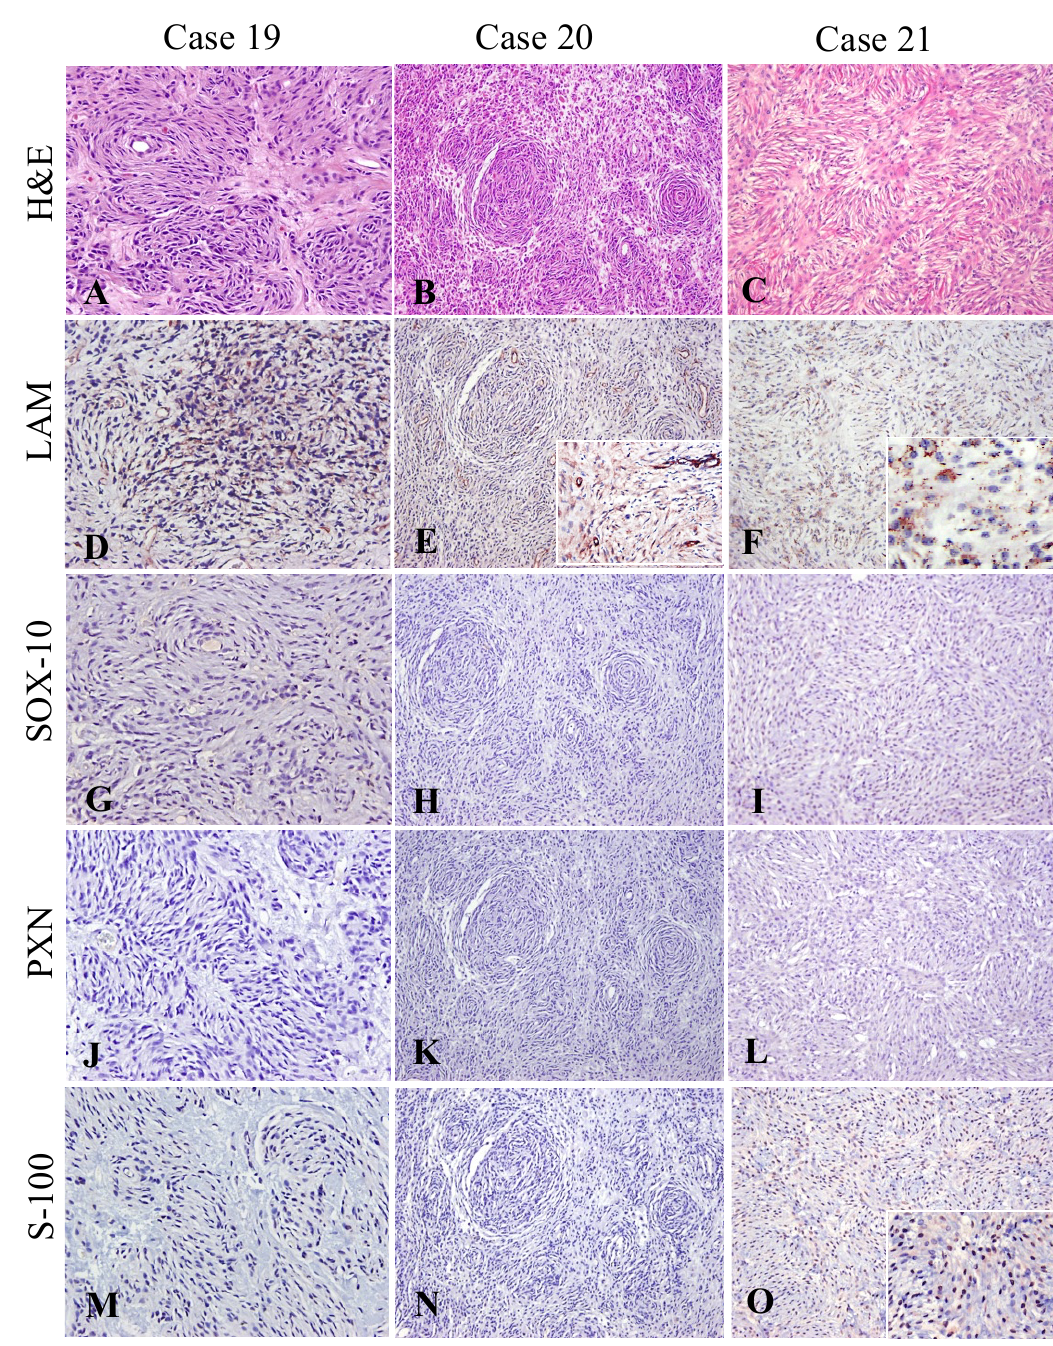
Figure 3. Peripheral nerve IHC panel phenotype of perivascular wall tumors (PWT). The nerve markers to be tested in PWT included laminin (LAM), Sox-10, periaxin-1 (PXN) and S-100. ( A – C ) H&E of each NST sub-type is given for histomorphological context. ( D – F ) All PWT display patchy areas of LAM immunoreactivity. Laminin variably decorated the cytoplasm of some neoplastic cells in a discontinuous stippled dotting pattern (insets in E and F ). None of the PWT immunoreacted to Sox-10 ( G – I ) or PXN ( J – L ). S-100 immunopositivity was not detected in two PWT cases ( M , N ). In the third PWT case, Case 21, S-100 decorated the cytoplasm of some cells ( O ,